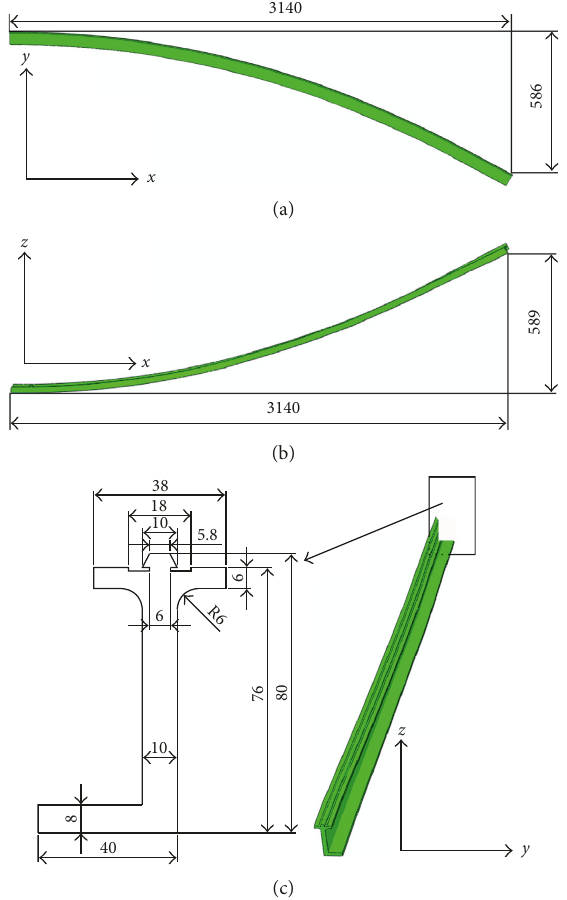
Figure 6: The 3D stretch bending parts. (a) Vertical view. (b) Front view. (c) Right view and the geometry size of the